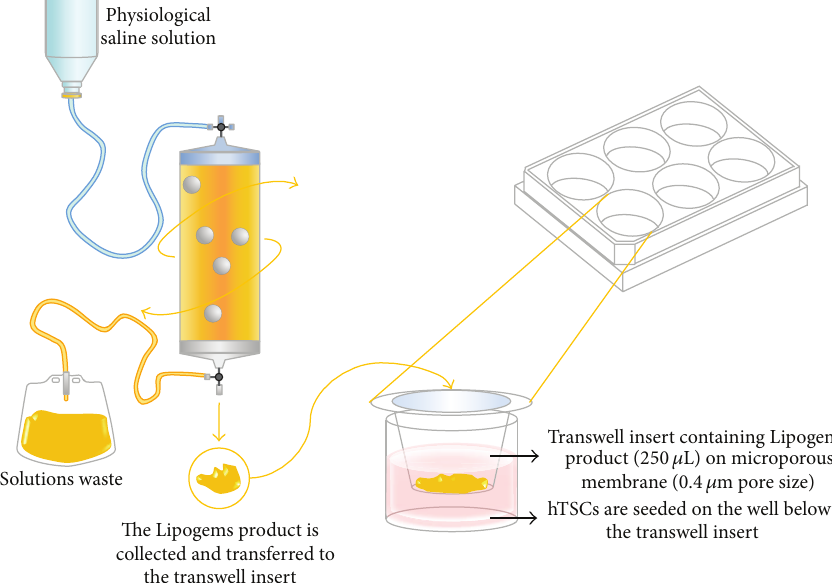
Figure 1: Schematic illustration of the Lipogems device and the transwell coculture system of hTSCs with the Lipogems product. The lipoaspiratewasprocessedusingtheLipogemsdevicetoobtainthefinalLipogemsproduct.Atranswellcoculturesystemwasusedtostudythe effects of the Lipogems product on primary cultures of hTSCs. Cells were seeded on the bottom of a 6-well plate in normal growth medium. Twenty-four hours after plating, the Lipogems product was transferred in the upper well of a transwell cell culture system (250 𝜇 L/transwell insert), separated from hTSCs in the lower well by a 0.4 𝜇 m microporous polycarbonate membrane. hTSCs and Lipogems product were maintained in coculture for successive